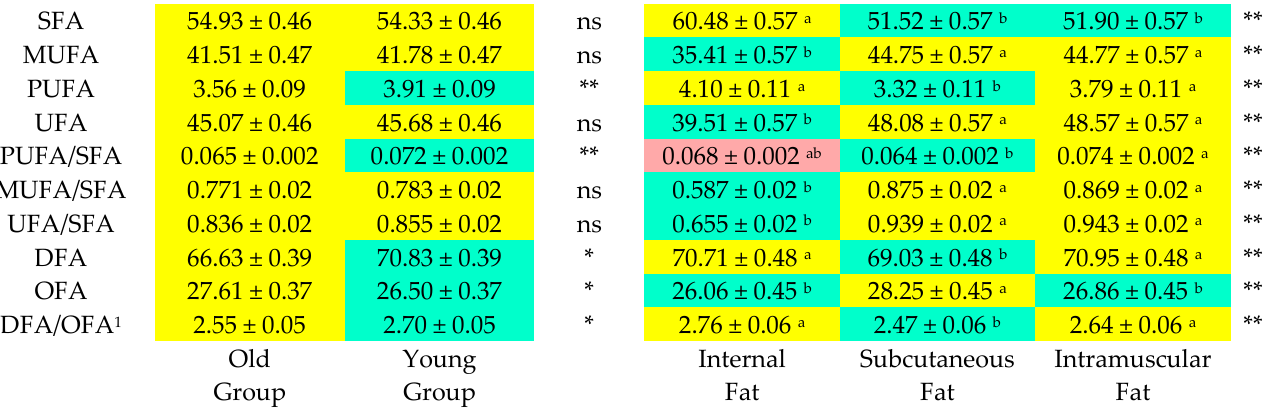
Figure 2. Heatmap plot of fatty acids profile of different fat types of the carcasses of bulls depending on slaughter ages. 1 DFA/OFA: hypocholesterolemic/hypercholesterolemic; *: p < 0.05; **: p < 0.01; ns: non ‐ significant; a,b : Values in rows with different letters and colors differ sig.